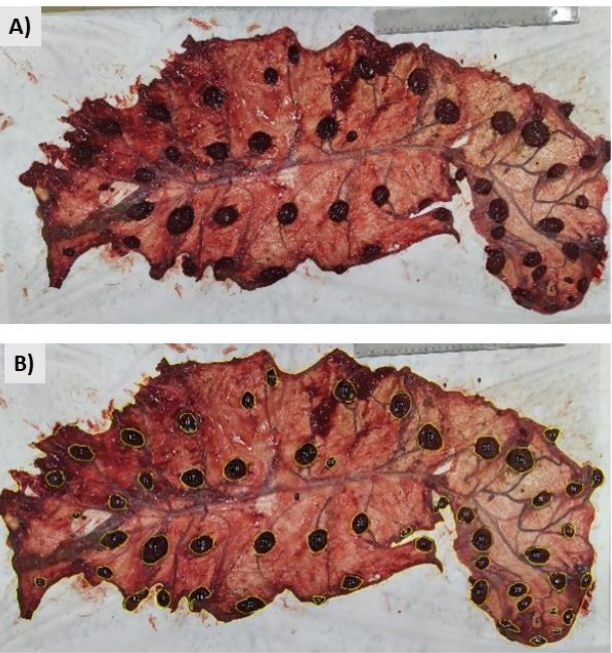
Figure 2. Representation of area measurement. ( A ) Placenta of single-gestation ewe. ( B ) Markings (yellow lines) and area and cotyledon numbering in ImageJ.